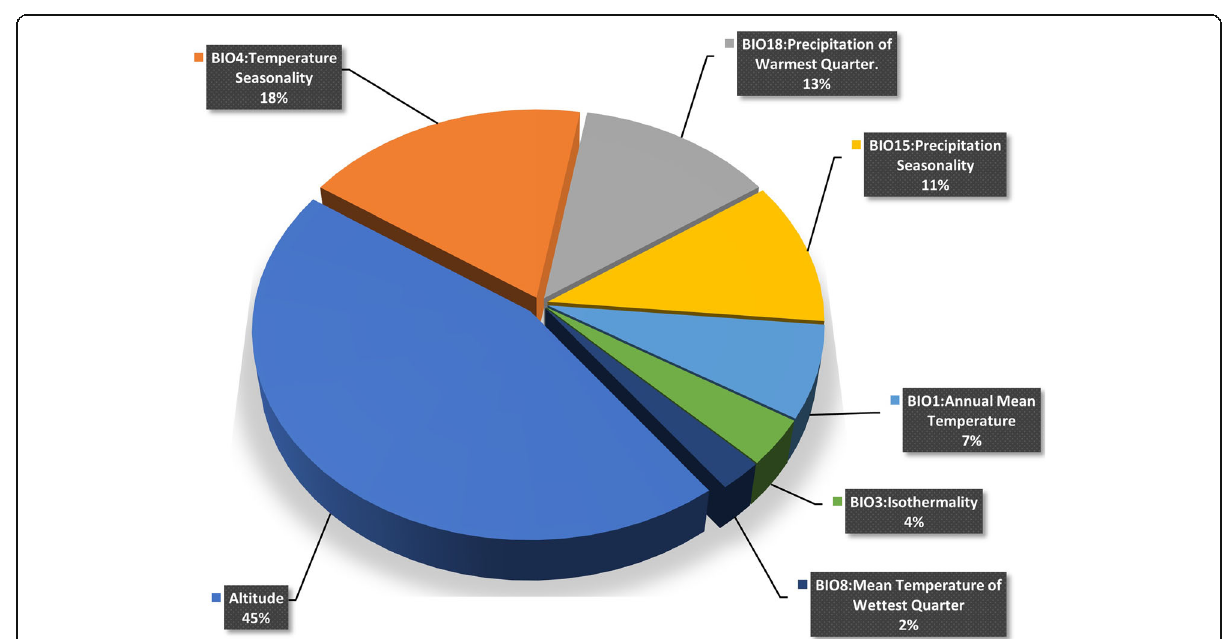
Fig. 10 Analysis of variables contributes to the prediction distribution model of S. buboniae